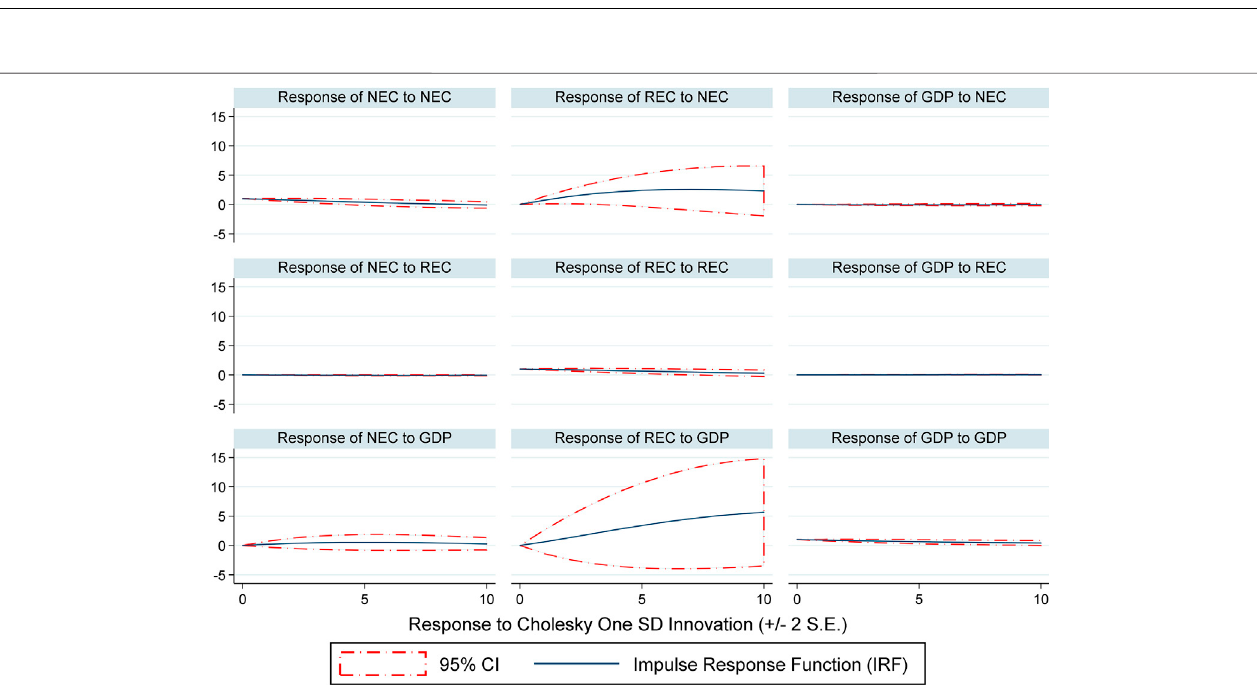
FIGURE 5 | Impulse Response Functions for Germany. Source: our elaboration.